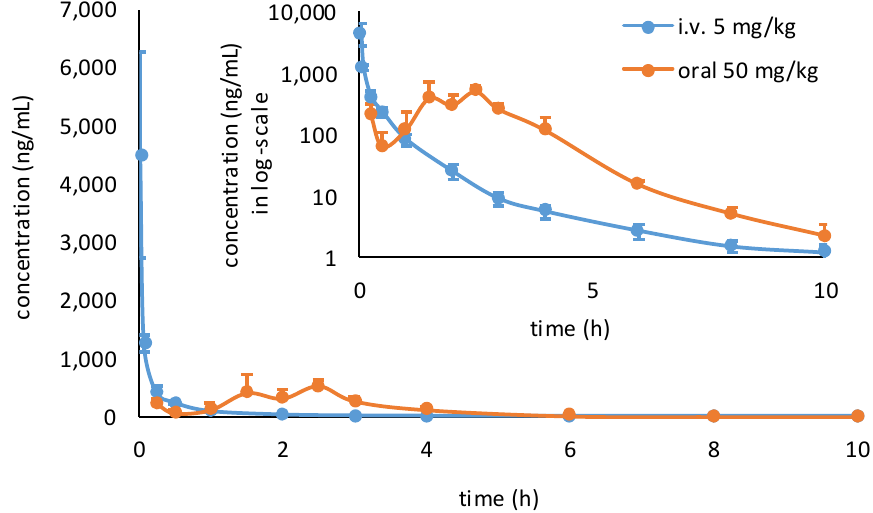
Figure 7. Mean plasma concentration vs. time profiles of MPI8 in rat plasma after i.v. ( n = 3) and oral